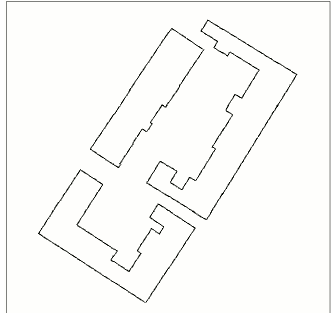
Figure 2d. Building boundaries after